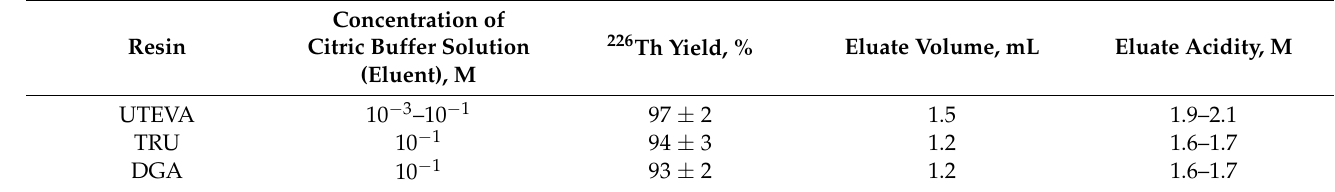
Table 1. Characteristics of 226 Th eluted from the second column of 230 U/ 226 Th generator with citric buffer solution.